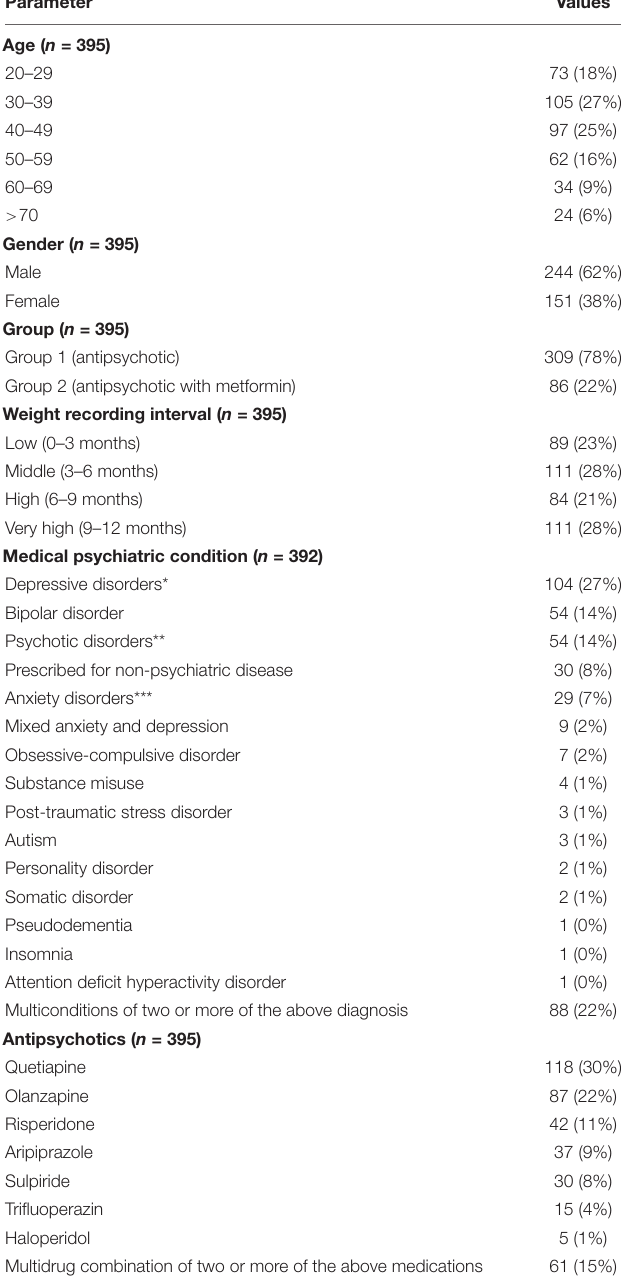
TABLE 1 | Patient demographic characteristics, medical conditions, and